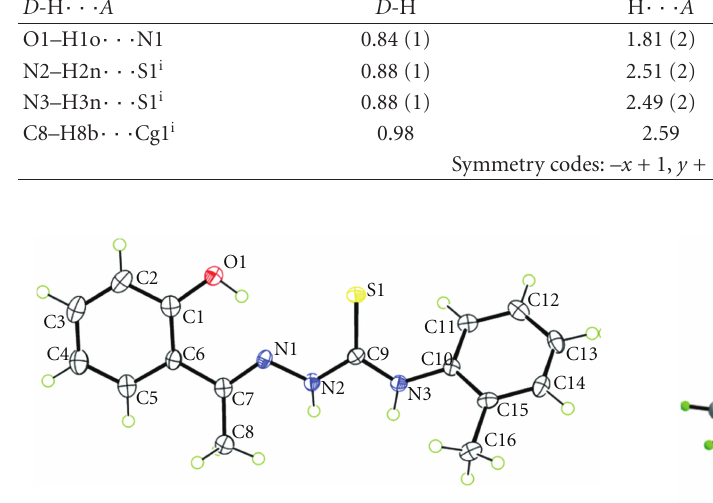
Figure 1: The molecular structure of H 2 dampt ( 1 ) showing the atom-labelling scheme and displacement ellipsoids at the 50% probability level.